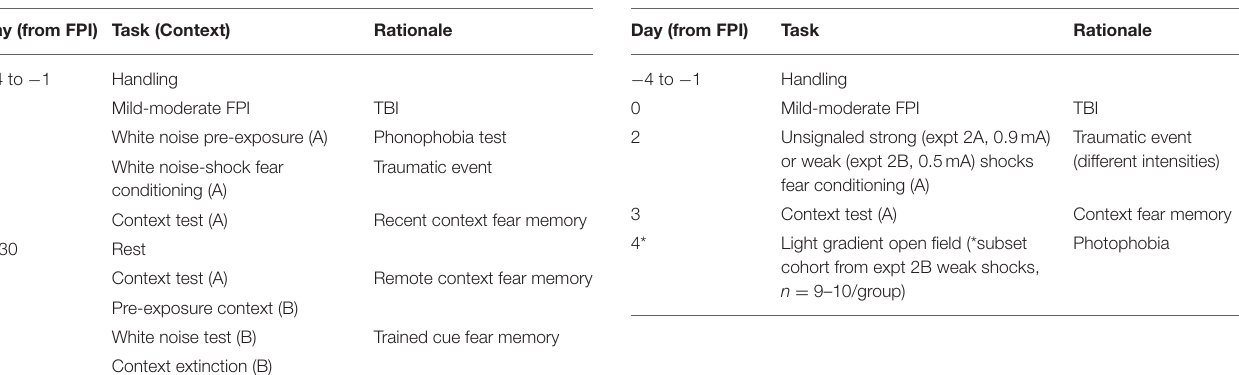
TABLE 1 | Experiment 1 timeline and description. TABLE 2 | Experiment 2 timeline and